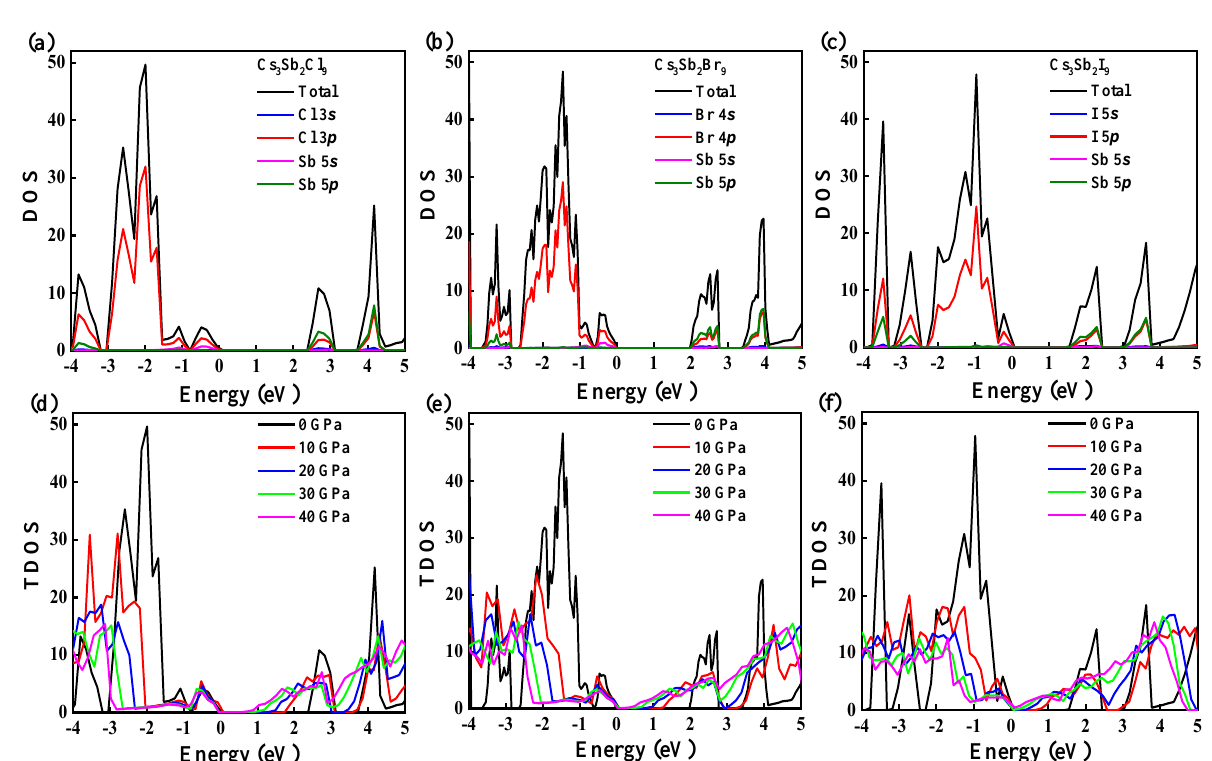
Figure 5. Total and partial density of states for Cs 3 Sb 2 Cl 9 ( a ); Cs 3 Sb 2 Br 9 ( b ); and Cs 3 Sb 2 I 9 ( c ); are calculated by PBE functional. Total density of states of Cs 3 Sb 2 Cl 9 ( d ); Cs 3 Sb 2 Br 9 ( e ); and Cs 3 Sb 2 I 9 ( f ); under different pressures.